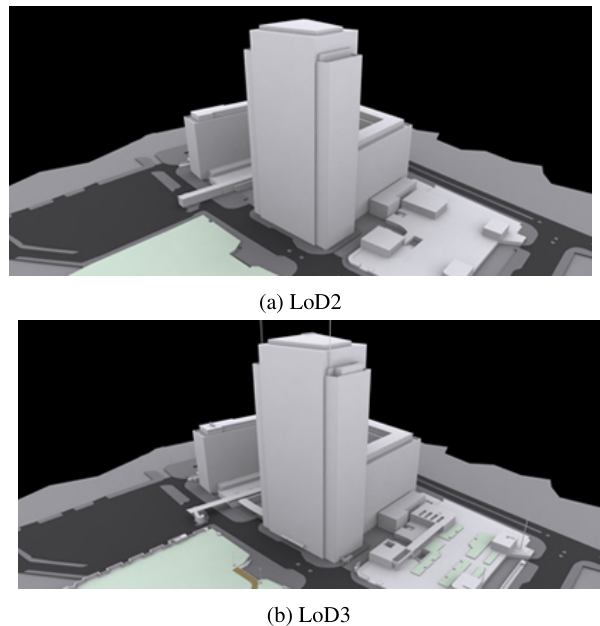
Figure 4: An example of 3D city models in level of detail 2 and 3 produced by Vertex Modelling. The images are reproduced from the producer’s website.